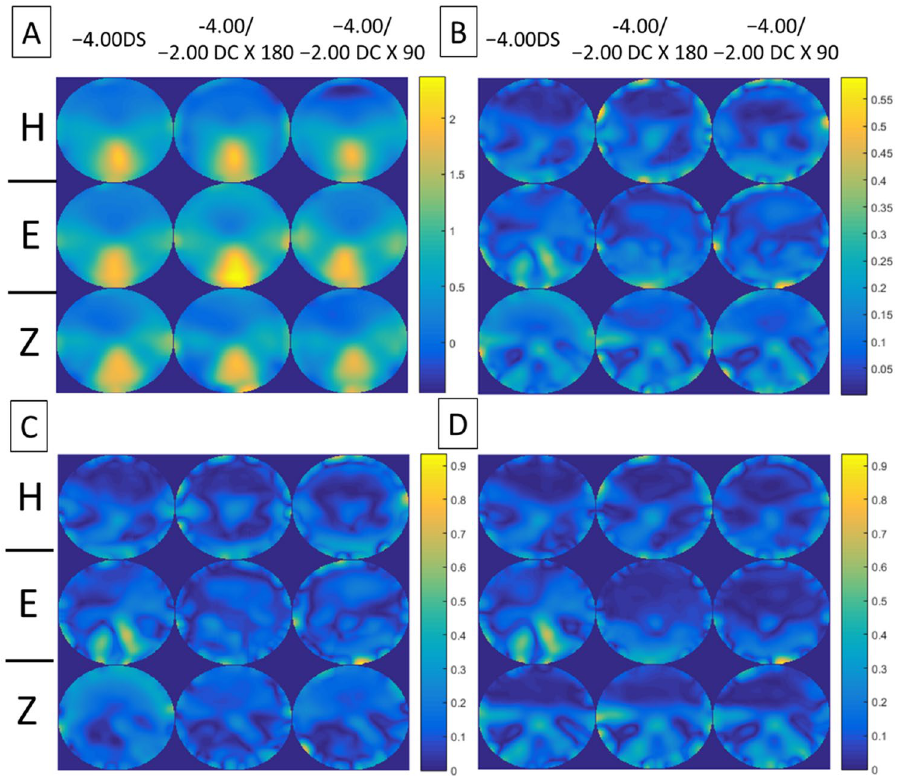
Figure 4. Error maps of spherical power, (cid:31) M . ( A ) Mean and ( B ) standard deviation of the error maps at distant viewing distance for four lenses (2 models × 2 corridor lengths) with the same prescription (columns) from the three lens manufacturers (rows: H Hoya, E Essilor, Z Zeiss). ( C ) and ( D ) show mean absolute differences of the error maps for PALs of different models and corridor lengths, respectively. Note that the scales of color-coded maps are